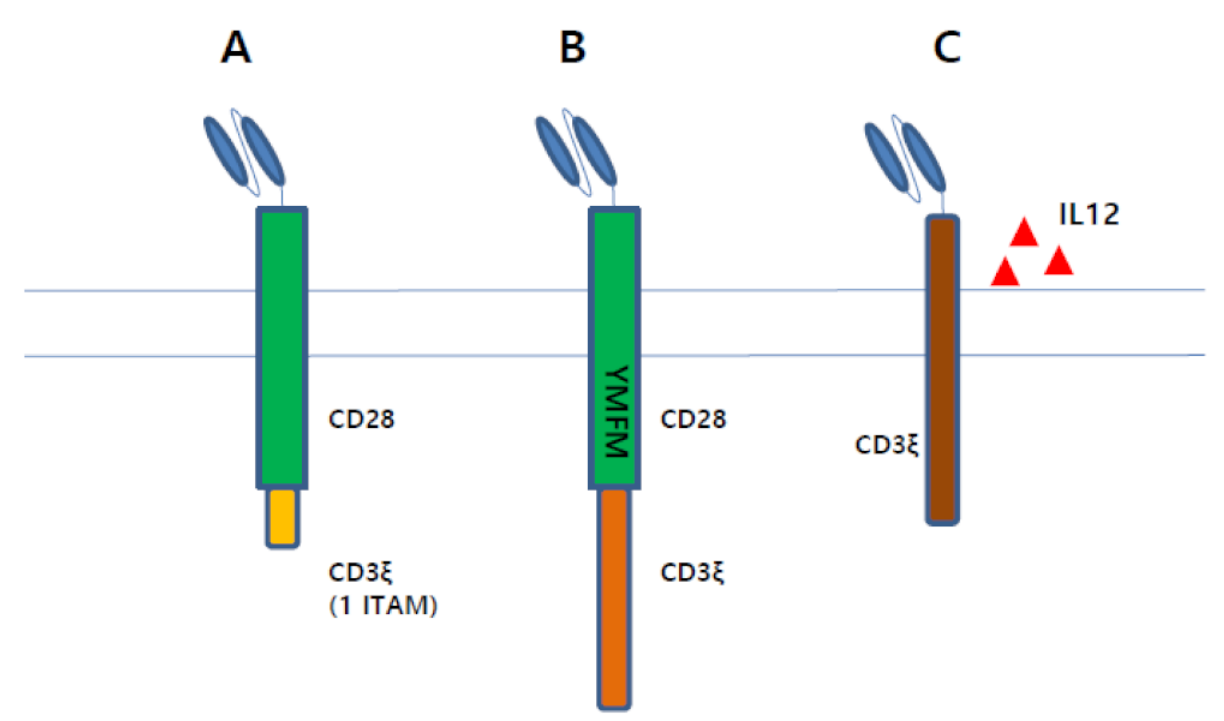
Figure 2. CAR constructs designed to exhibit reduced T cell activation are likely to achieve enhanced preclinical results. ( A ). A CAR construct containing single ITAM in CD3 ζ endodomain demonstrates excellent anti-tumor effect. ( B ). Defect in binding with Grb2 by mutant encoding YMFM instead of YMNM in CD28 endodomain reduced T cell exhaustion, which leads to excellent anti-tumor effect. ( C ). First-generation CAR T cells secreting IL12 is superior to second-generation CAR T